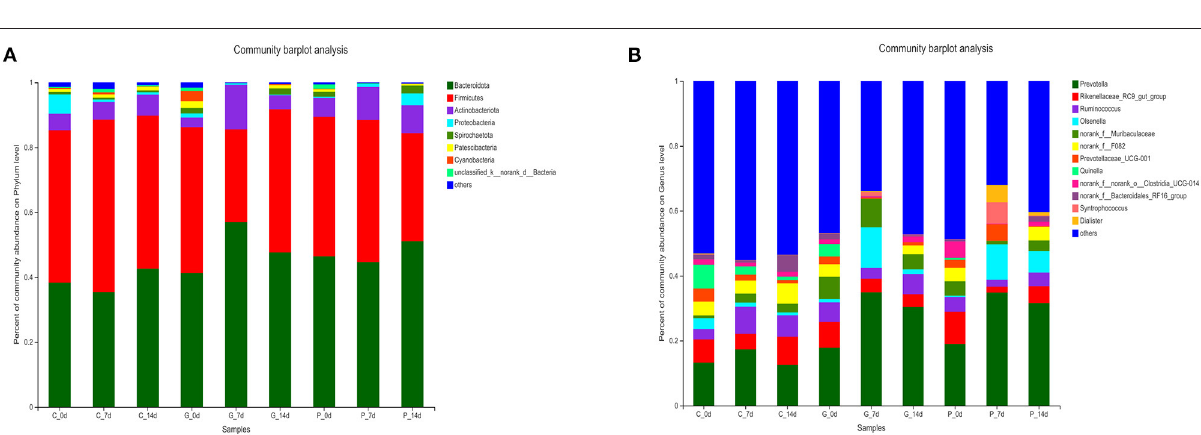
rumen-protected granules low-dose group, chlortetracycline premix group, and infection control group ( χ 2 = 0.46 and 3.79, respectively). During the trial, no death was found in each